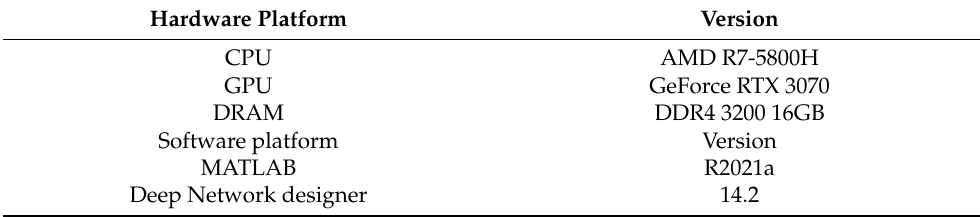
Table 3. The hardware and software platform.